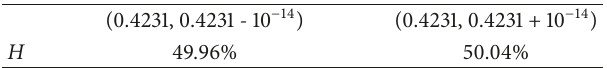
Table 4: The difference between generated binary sequences with different 𝑝 0 .